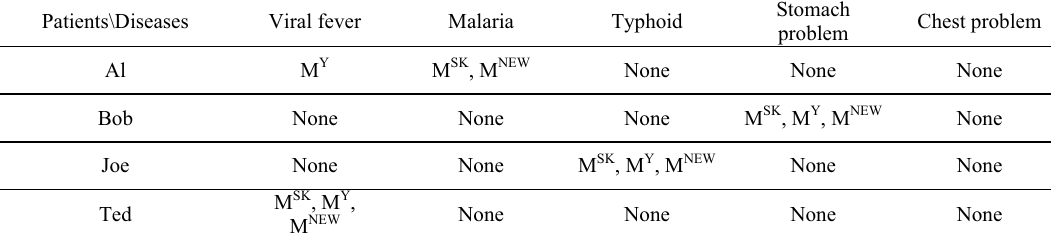
Table 4. A comparison for different similarity measures